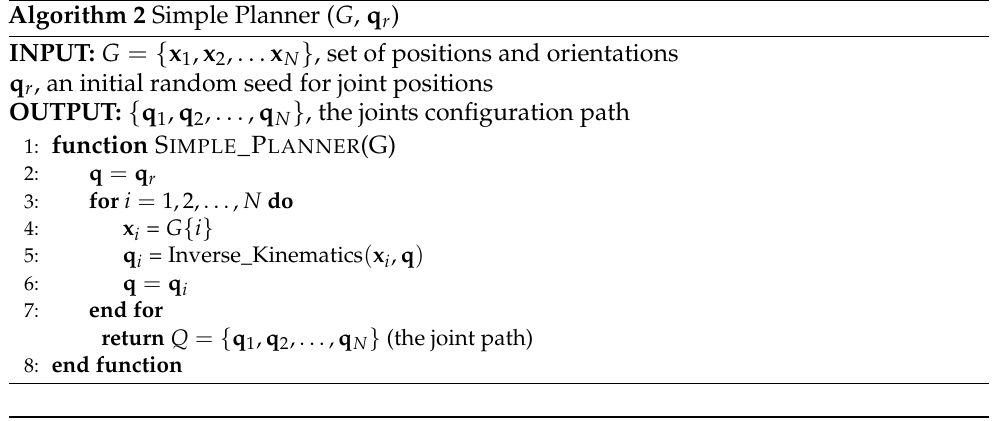
Algorithm 2 Simple Planner ( G , q r )